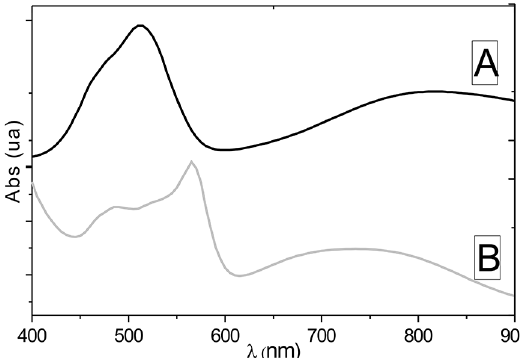
Figure 1. Electronic spectra of (A) Solution 1 - 0.02 mol L −1 CuSO4.5H2O and 0,10 mol L −1 CoSO 2 - 0.02 mol L −1 CuSO 0.50 mol L −1 sodium tartrate Na